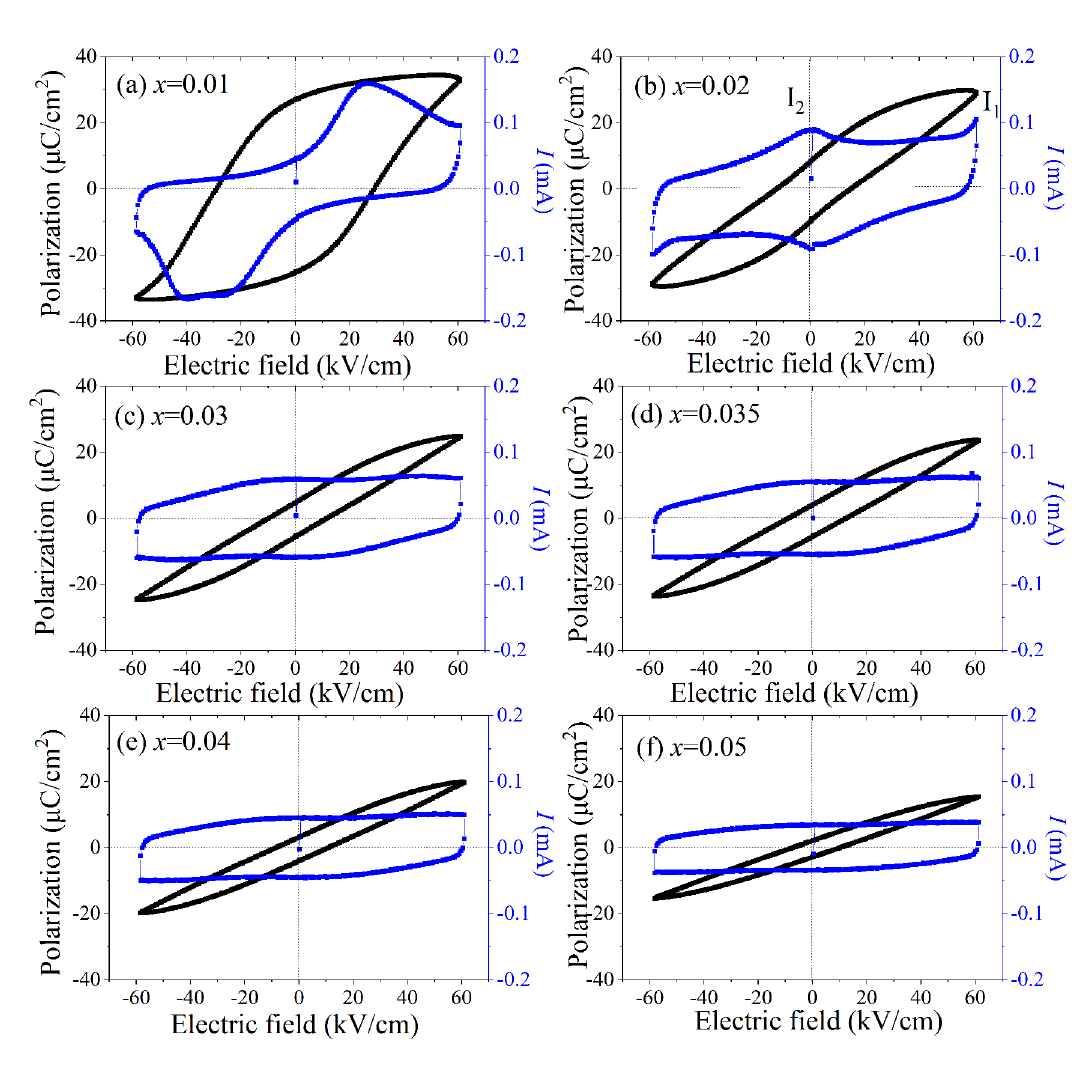
Figure 5. P-E and I-E loops of BNBT- x NT ceramics